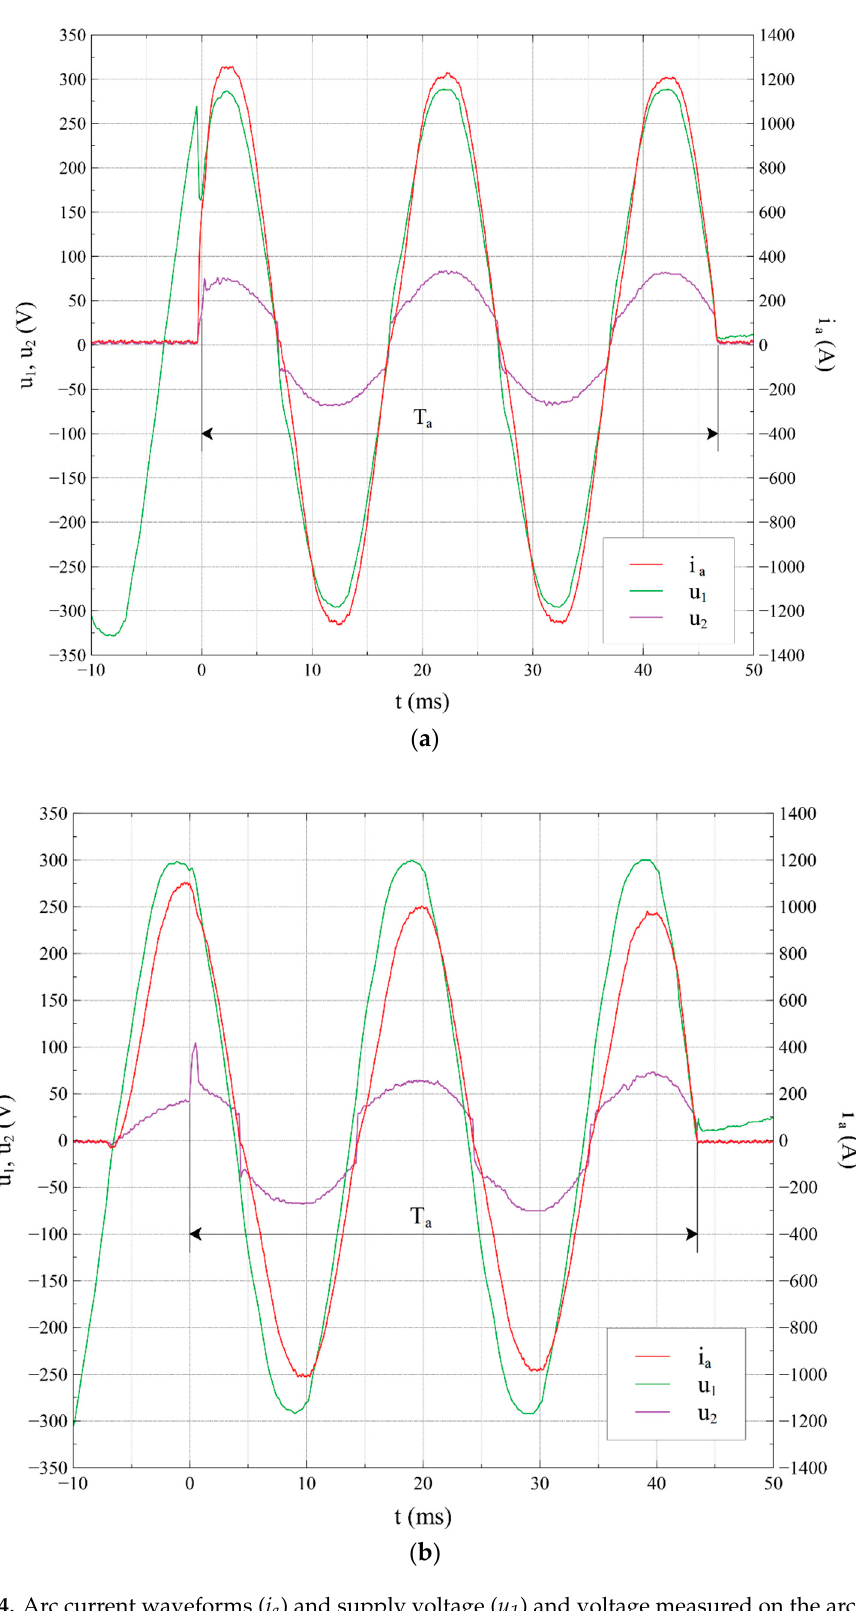
Figure 4. Arc current waveforms ( i a ) and supply voltage ( u 1 ) and voltage measured on the arc source electrodes ( u 2 ) in a circuit in which thyristor Th1 and thyristor Th2 are not triggered: ( a ) L R = 0 µH, arc time T a = 47 ms; ( b ) L R = 163 µH, arc time T a = 43.5 ms.